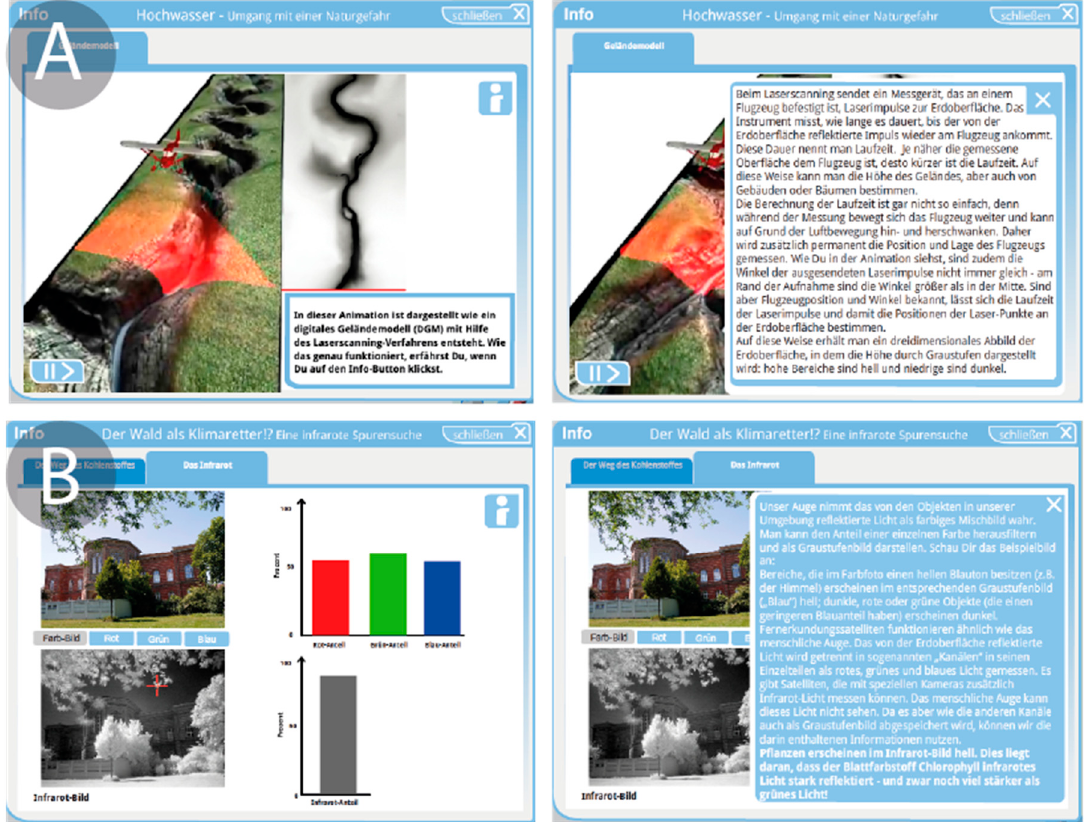
Figure 3. The “Multiple Representations Principle” in action. ( A ) shows a screenshot of the learning environment “Floods” with an interaction about the creation of a digital terrain model. Text and interaction complement each other. ( B ) shows an example of the module “Forests—A Climate Saver?” where an interactive component alongside a text explains how infrared is depicted in an image (Source: see Appendix